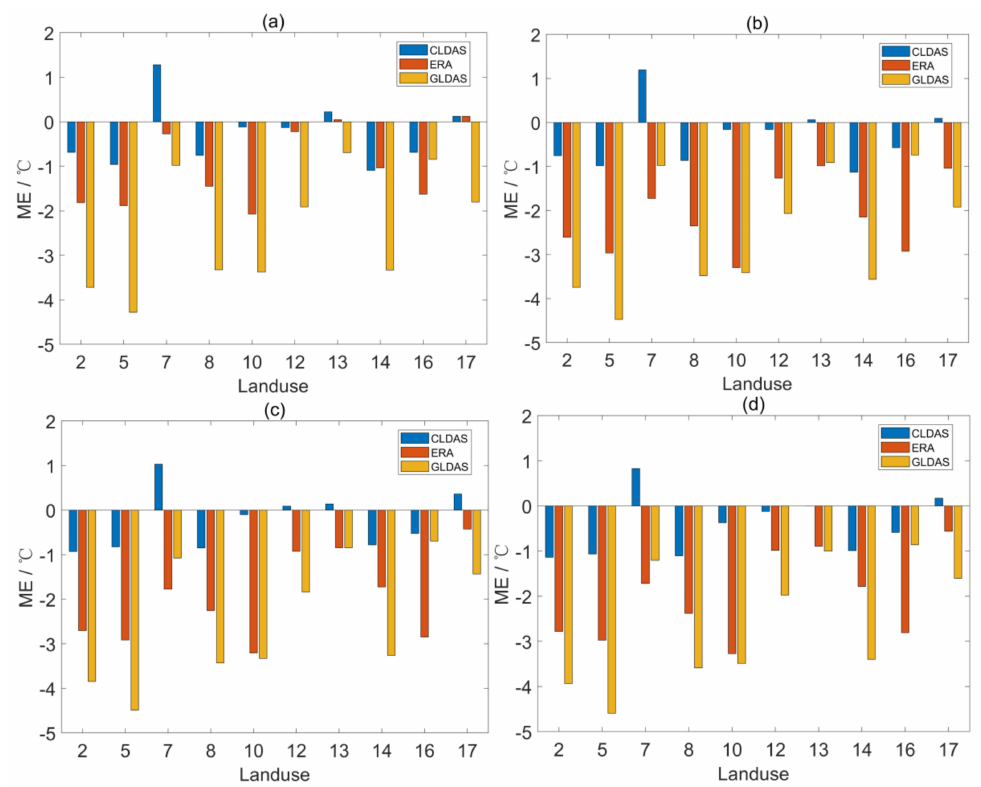
Figure 10. ME of soil temperature in different land-use: ( a ) ST10, ( b ) ST20, ( c ) ST40, and ( d )